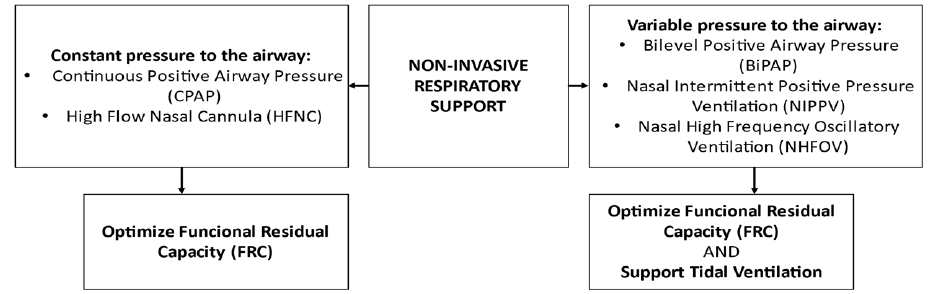
Figure 1. Different non-invasive respiratory support